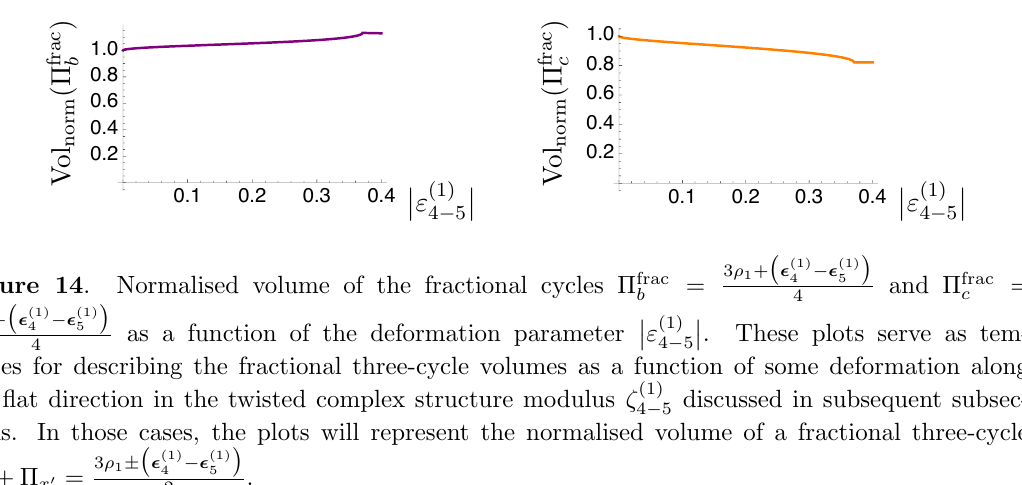
(cid:0) (cid:1) (cid:26) 1 (cid:0) (cid:15) (1) 4 (cid:0) (cid:15) (1) 5 = and (cid:5) frac = a d 4 (cid:12) (cid:12) (1) (cid:12) " (cid:12) , with the bulk cycle (cid:5) bulk ly- 4 (cid:0) 5 = Z 6 as argued in section 2.4.2. These plots serve as templates for (1) in the subsequent subsections. In those cases, 4 (cid:0) 5 (cid:0) (cid:1) (cid:26) 1 (cid:6) (cid:15) (1) 4 (cid:0) (cid:15) (1) 5 . 2